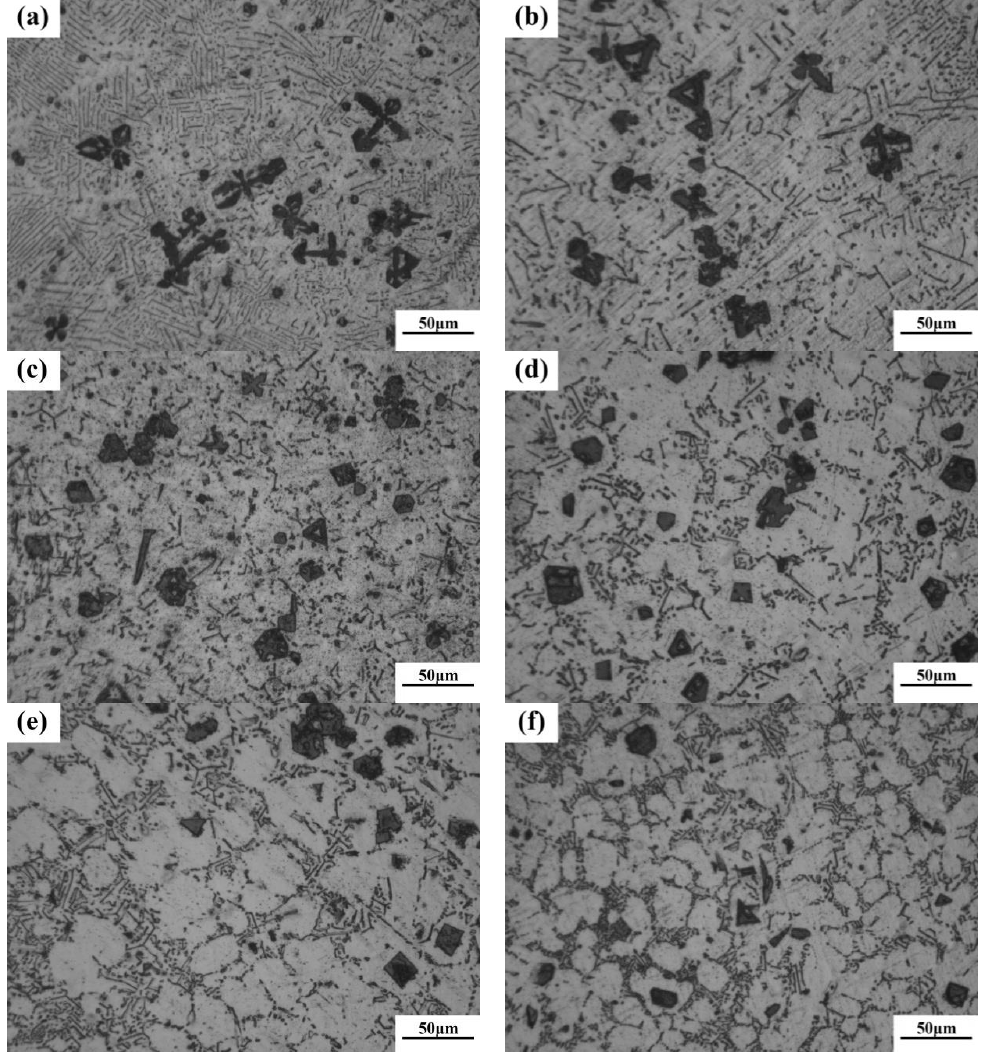
Figure 6. The optical micrograph (OM) images of as-cast Mg – 4Si – yCa (y = 0 wt.%, 0.2 wt.%, 0.4 wt.%, 0.6 wt.%, 0.8 wt.%, 1.0 wt.%). ( a ) 0% Ca; ( b ) 0.2% Ca; ( c ) 0.4% Ca; ( d ) 0.6% Ca; ( e ) 0.8% Ca; ( f ) 1.0% Ca.